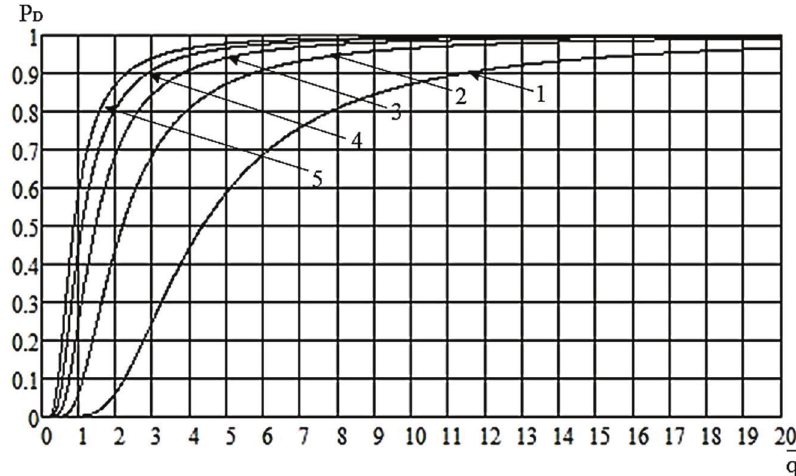
Fig. 3. Detection characteristics of an autonomous radar station in comparison with a spatially coherent MIMO radar system for the case when the radar stations of the system operate simultaneously in a transceiver mode with a false alarm probability P F =10 -6 : 1 – for an autonomous radar station; 2 – when using 2 radar stations in the system; 3 – when using 3 radar stations in the